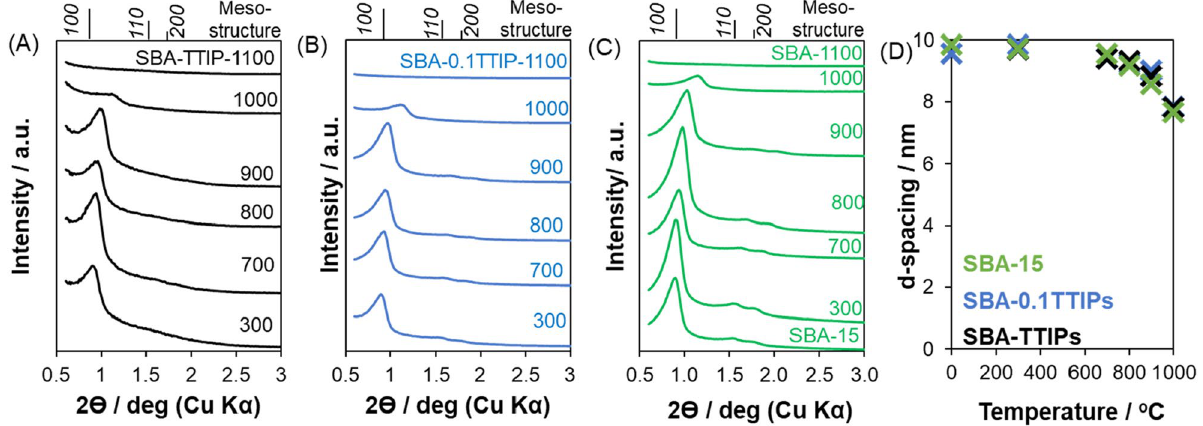
Figure 4. Low-angle X-ray powder diffraction patterns of the heated ( A ) SBA-TTIPs, ( B ) SBA-0.1TTIPs and ( C ) SBA-15, and the changes in d(100) -spacing ( D ) of the heated SBA-15 (green), SBA-0.1TTIP (blue) and SBA- TTIP (black), derived from Bragg’s equation as a function of the heating temperature.